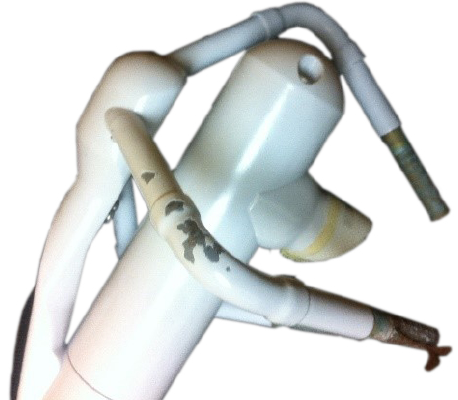
Figure 2. The eddy-covariance station located in the coastal landfast sea ice area of Antarctica Zhongshan Station (69 ◦ 22 (cid:48) S, 76 ◦ 22 (cid:48) E). It was configured with the IRGASON integrated CO 2 /H 2 O open-path gas analyzer and three-dimensional sonic anemometer, CNR4 four-component net radiometer, HMP155A air temperature and relative humidity probe, and SI-111 infrared ra- diometer.